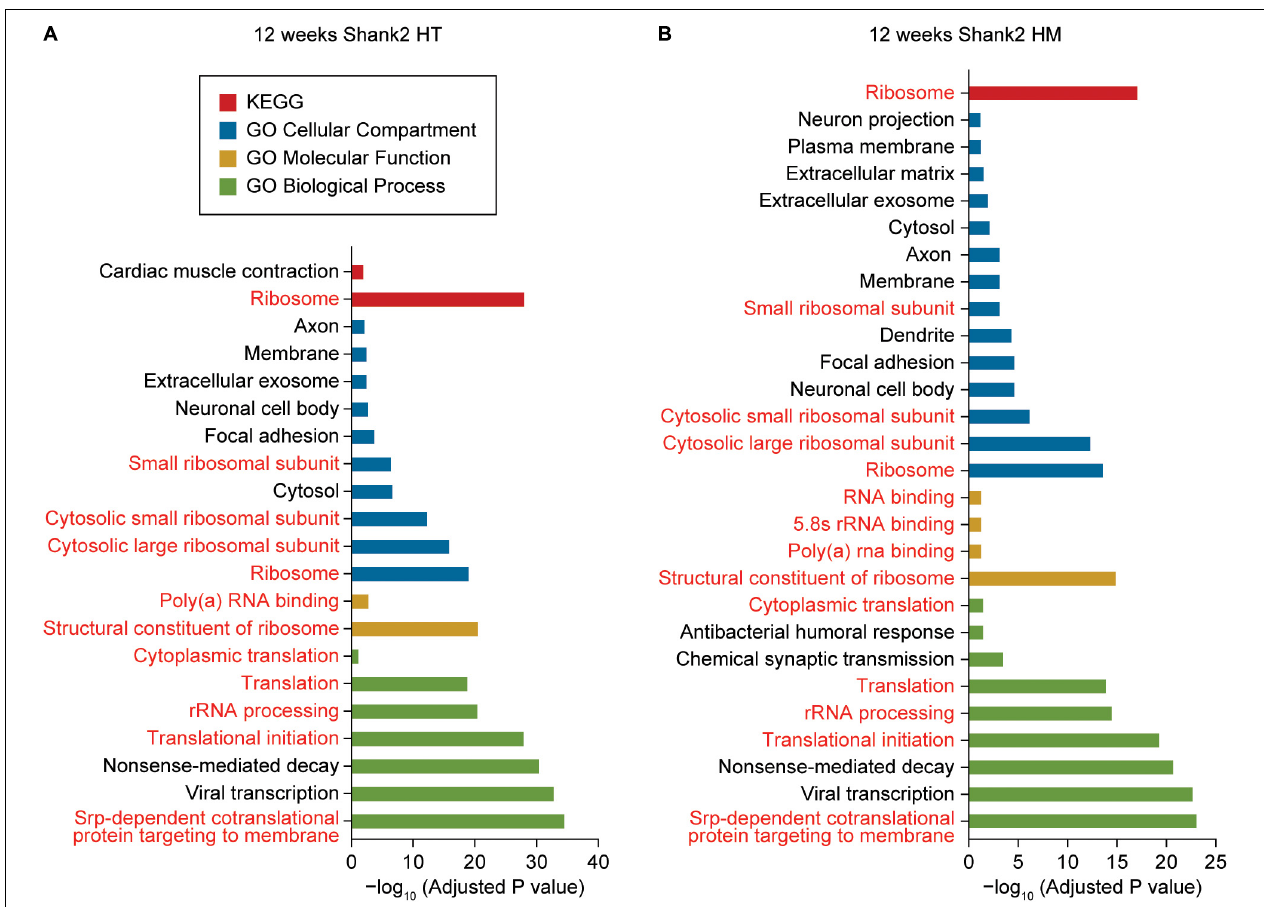
FIGURE 2 | DAVID gene ontology analyses of DEGs from W12-HT and W12-HM Shank2 -mutant mice. (A,B) DAVID gene ontology (GO) analysis of DEGs from W12-HT and W12-HM Shank2 -mutant mice (adjusted p -value < 0.05). Ribosome/translation-related GO terms are indicated in red.